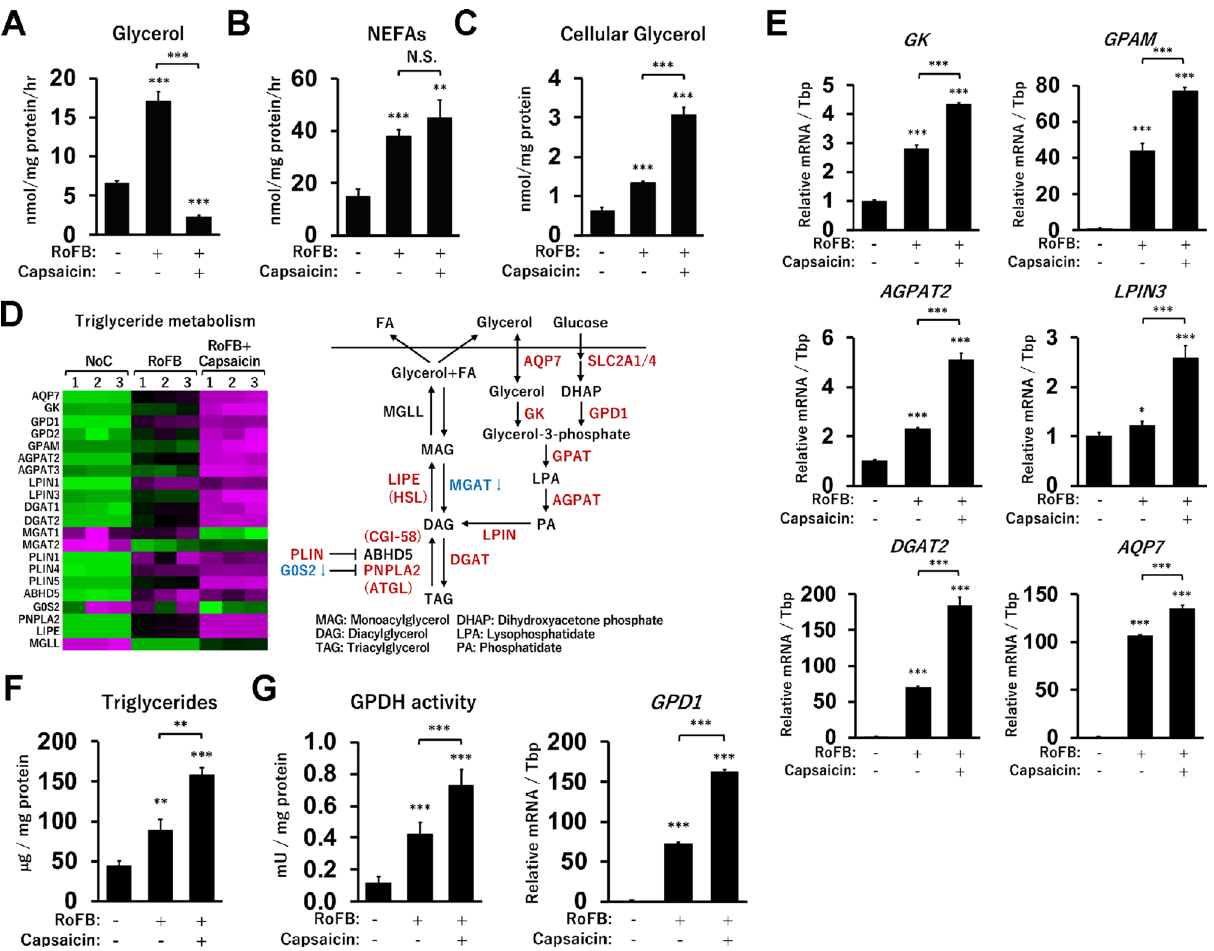
Figure 5. Glycerol and triglyceride metabolism in Capsaicin-treated ciBAs. ( A,B ) The secretion of glycerol ( A ) and non-esterified fatty acids (NEFAs) ( B ) into the culture medium was measured in the control, ciBAs, and Capsaicin-treated ciBAs. ( C ) Cellular glycerol levels were also measured. ( D ) A heat map represents the transcriptional changes of metabolic genes related to triglycerides metabolism. The color scale shows z-scored FPKM representing mRNA levels of each gene in green (lower expression) and magenta (higher expression). A schematic figure shows triglyceride metabolic pathway including up-regulated genes (highlighted by reddish- brown) and down-regulated genes (highlighted by blue) in Capsaicin-treated ciBAs. ( E ) The expression of GK , GPAM , AGPAT2 , LPIN3 , DGAT2 , and AQP7 was quantified by qRT-PCR analysis. ( F,G ) Cellular triglycerides ( F ) and GPDH activity ( G ) were measured in the control, ciBAs, and Capsaicin-treated ciBAs. GPD1 mRNA was quantified by qRT-PCR. Data represent mean ± SD (n = 3). Student’s t -test: * P < 0.05, ** P < 0.01, *** P < 0.001, N.S.; not